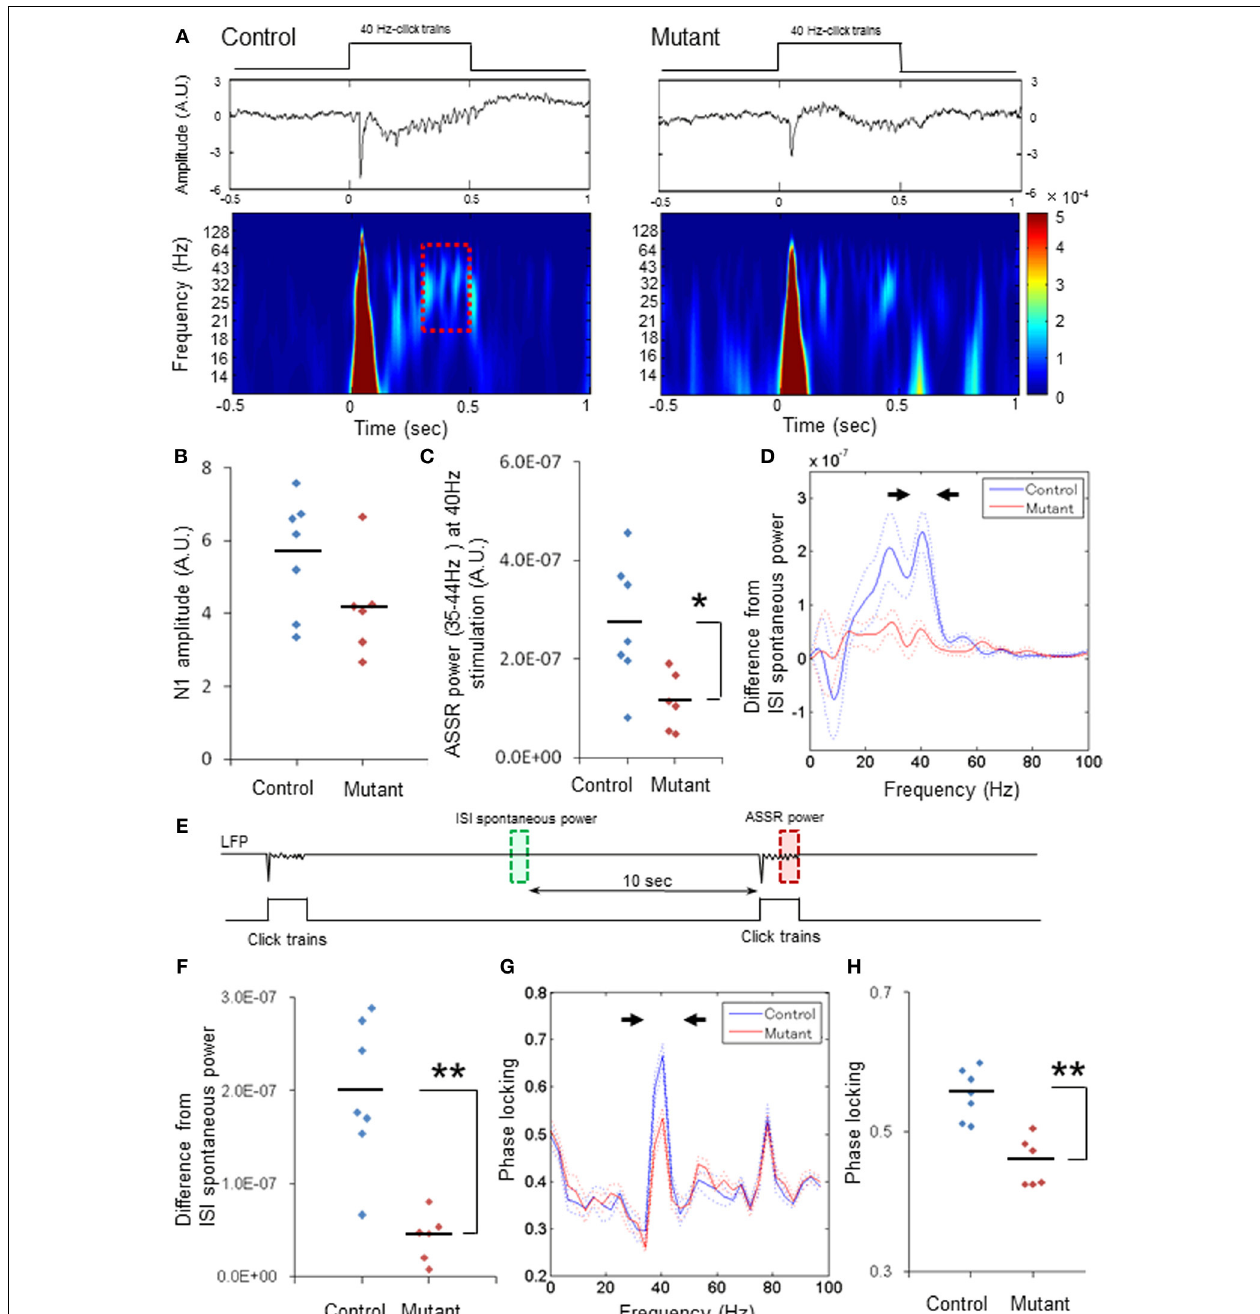
FIGURE 1 | Robustreductioninpower and phase-locking of40-HzASSRs. (A) Representativeexamplesoftheaveraged40-HzASSR(middle,z-score)and spectrogram (bottom) in response to 40-Hz click trains (upper; 80dB intensity, 500ms duration). Time 0 is tone onset. (B) No difference in the averaged N1 amplitudes (z-score) evoked by 40-Hz click trains between genotypes (blue for 7 fGluN1 control mice; red for 6 mutant mice). p = 0 . 11, unpaired Student’s t -test (C) Evoked ASSR power (z-score) at 35–44Hz frequency range during 40-Hz click train stimulation in mutants (red) was lower than controls (blue). ∗ p < 0 . 05, unpaired Student’s t -test. (D) The mean difference (A.U.) from baseline spontaneous power during inter-stimulus interval (ISIs; green square inPanel E )inclicktrain-evokedASSRpowerduringlast200msbeforecessation of 40-Hz click trains (red square in Panels A,E ). Dotted lines: mean ± s.e.m. (E)